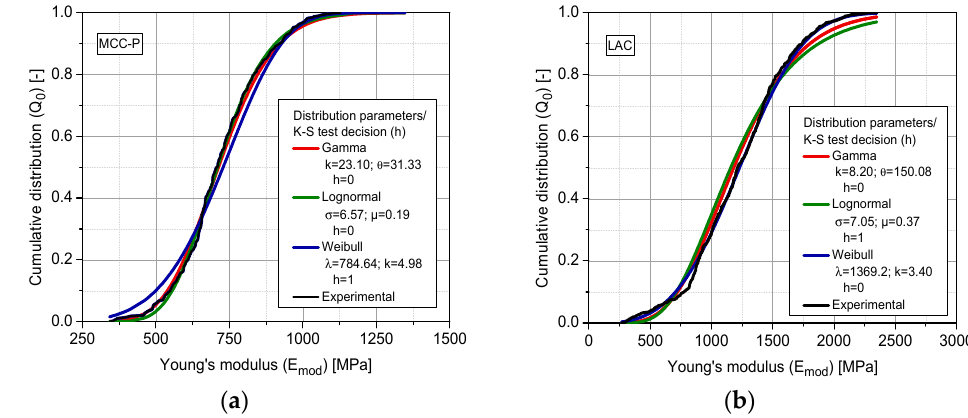
Figure 14. Fitted number cumulative distributions ( Q 0 ); ( a ) MCC-P 138.0 MPa upper face; ( b ) LAC 197.0 MPa upper face. The legend summarizes the fitted parameters for each distribution and the result of the Kolmogorov–Smirnov (K–S) hypothesis test. Sampling size: eight tablets per SF and face, 79 indents at each tablet.